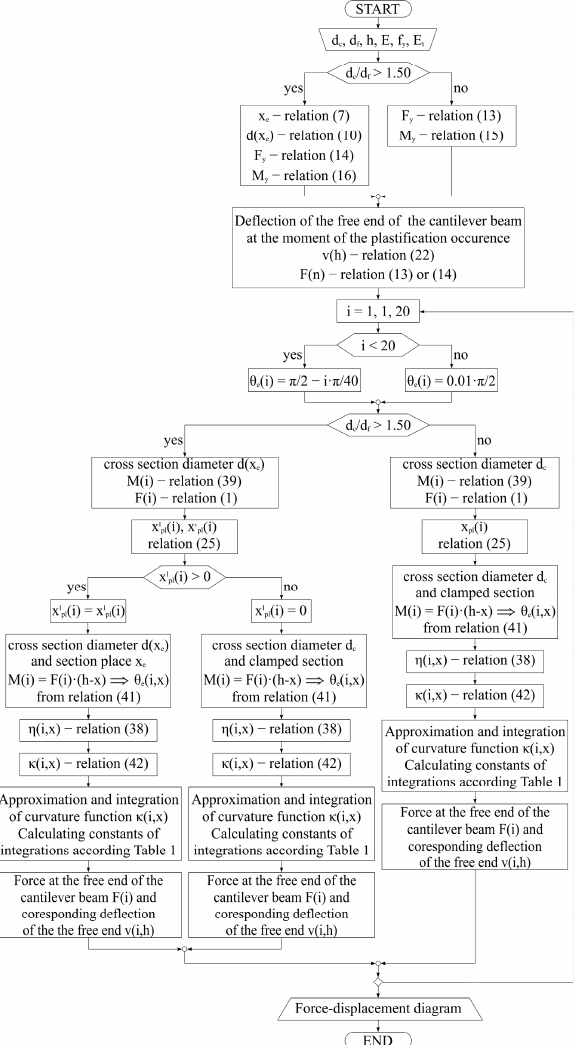
Figure 4. A flow chart of the semi-analytical algorithm.